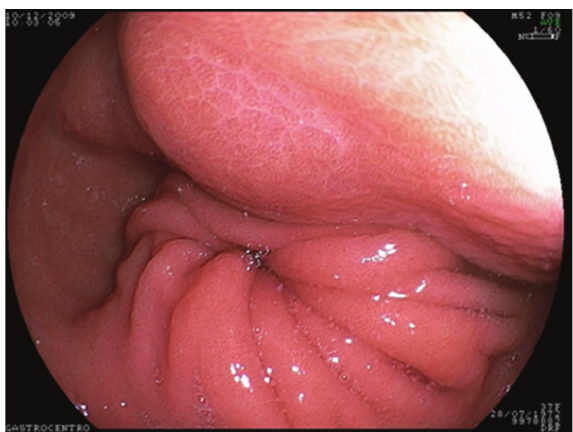
Figure 4: (H-E, 200x): Solid tumor cytologically composed of a compact proliferation of spindle cells arranged in a fascicular growth